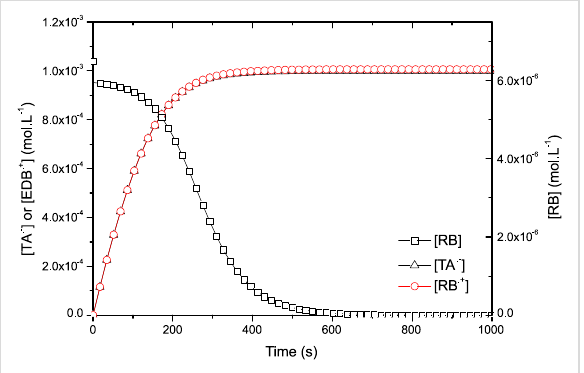
Figure 6: Evolution of radical concentrations TA • − and EDB •+ together with [RB] in photocatalytic system.